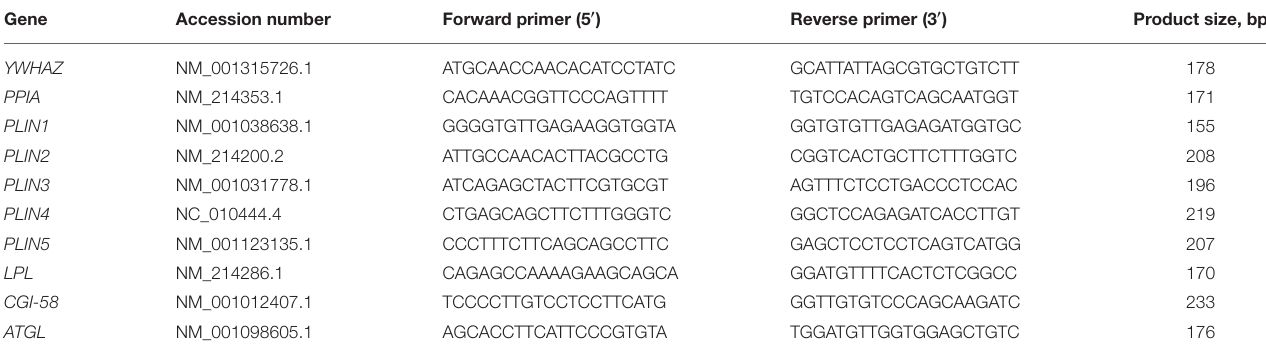
TABLE 1 | Primer sequences used for